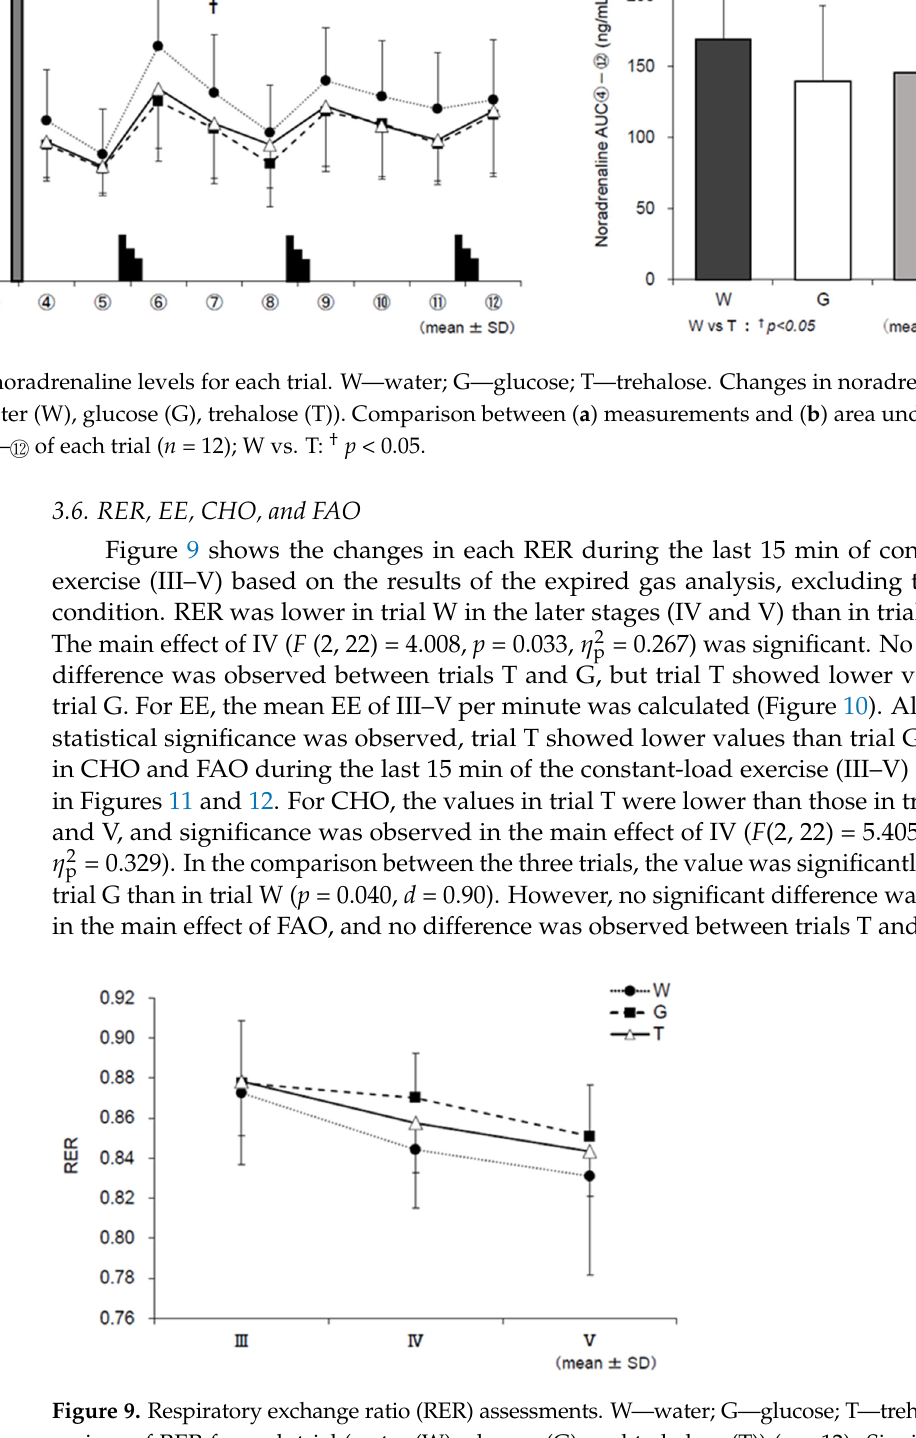
Figure 10. Energy expenditure (EE) assessments. W—water; G—glucose; T—trehalose. Compari- son of mean EE (kcal/min) in each trial (water (W), glucose (G), trehalose (T)) in III–V ( n = 12).